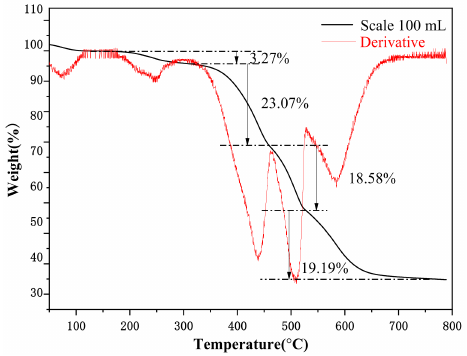
Figure 7. TG curves of MIL-121-scale 100